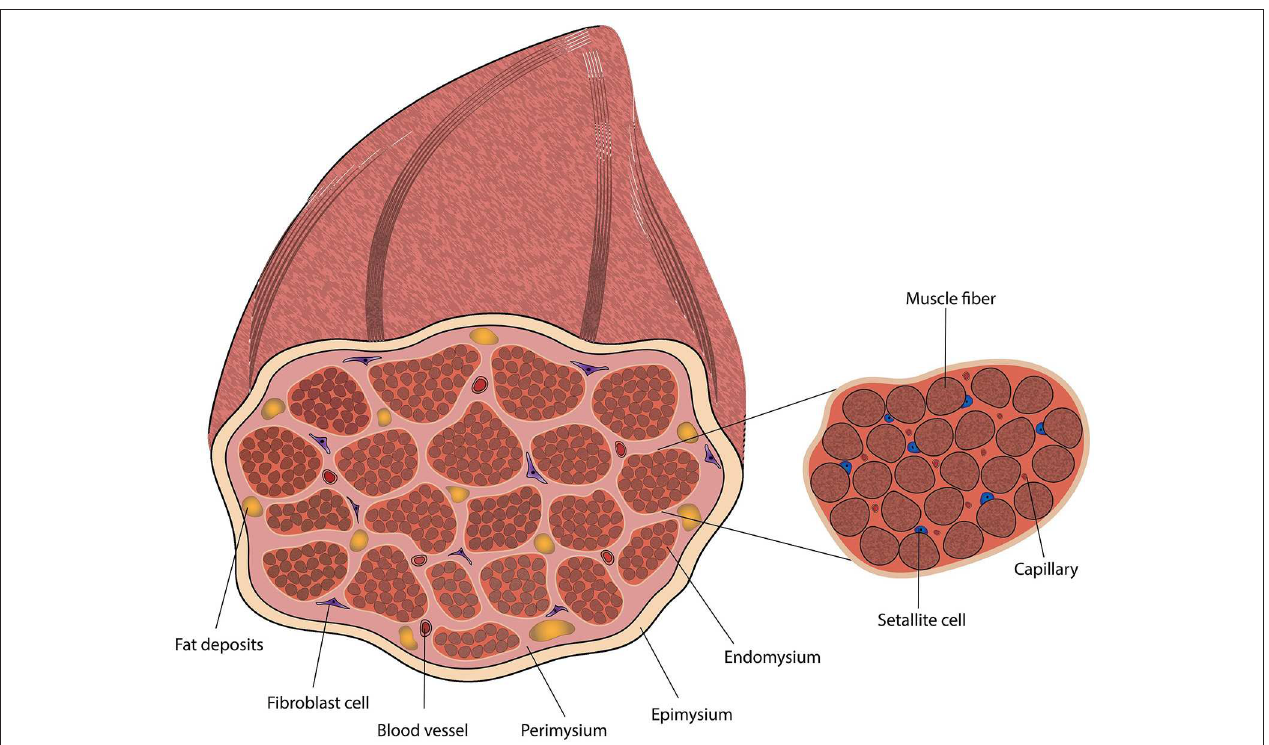
FIGURE 2 | Diagram of skeletal muscle tissue, including a magnification of a muscle